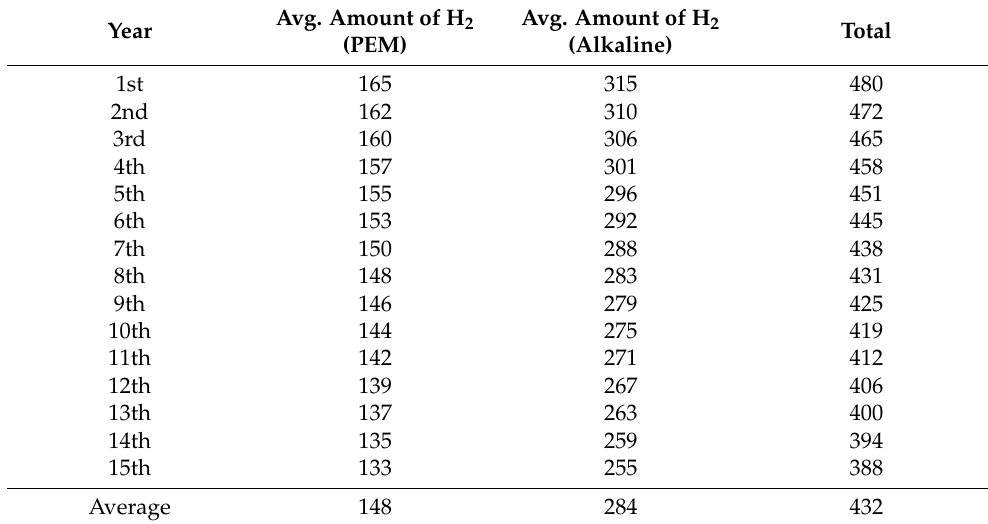
Table 40. The average daily amount of hydrogen produced for each year (Scenario